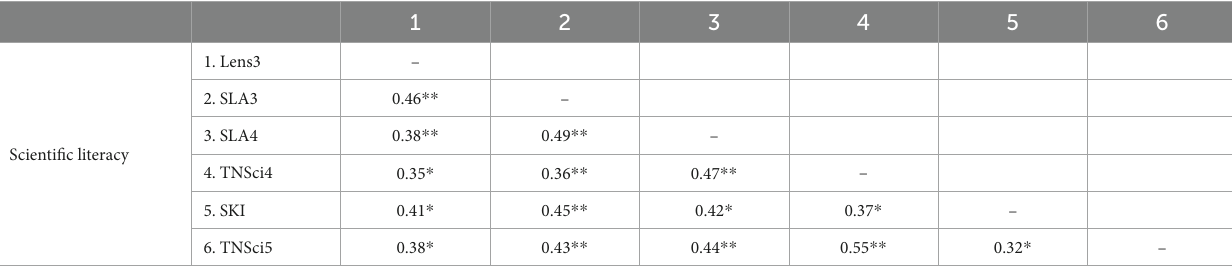
TABLE 5 Correlations for scientific literacy measures at Wave 3, 4, and